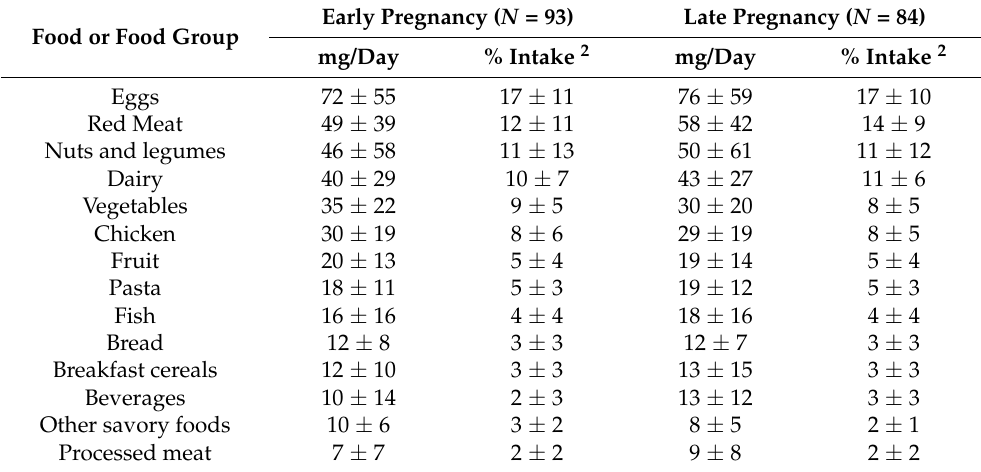
Table 3. Choline intake by reported DQES food or food group in early and late pregnancy 1